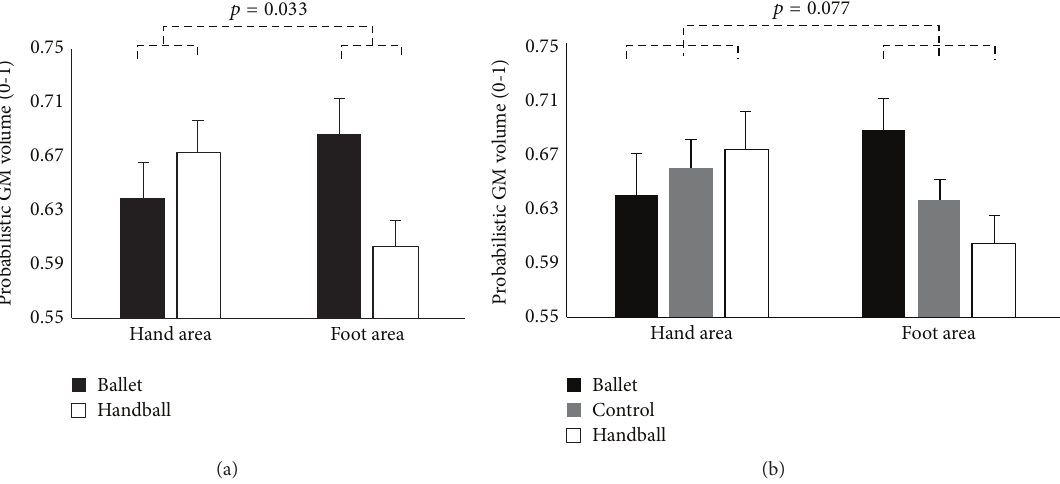
Figure 1: Estimated means and standard errors of GM volume of the hand and foot areas (independent of hemisphere and modality) for the ballet dancers ( 𝑛 = 10 ) and the handball players ( 𝑛 = 12 ) depicted on (a) (rmMANOVA including only the sports groups) and for the ballet dancers ( 𝑛 = 10 ) and the handball players ( 𝑛 = 12 ) and the control women ( 𝑛 = 22 ) depicted on (b) (rmMANOVA including all three groups). Note that increased GM reflects sport-specific